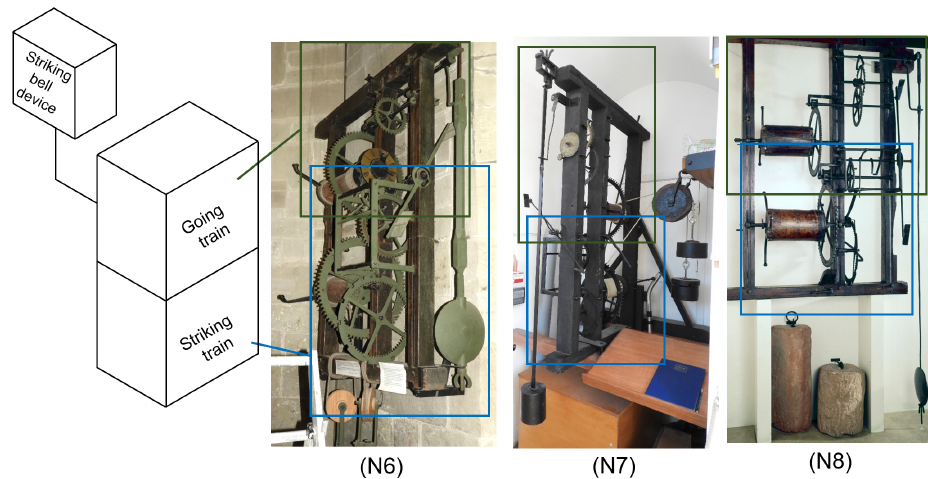
Figure 10. The structures of the Kempsey clock (N6) (Chadclocks, 2018a), Worcester clock (N7) (Chadclocks, 2018b), and Martley clock (N8) (Bridgemanimages, 2021).